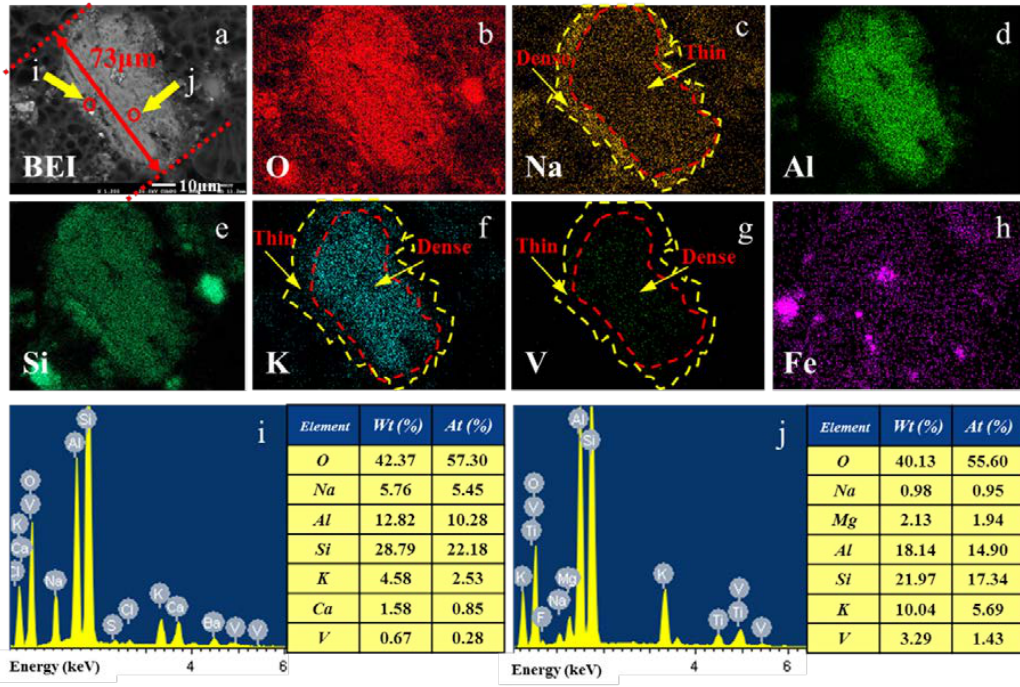
Figure 5. ( a ) BEI of acid leaching residue, EDS elemental distribution: ( b ) O, ( c ) Na, ( d ) Al, ( e ) Si, ( f ) K, ( g ) V, ( h ) Fe, and EDS spectra collected from BEI as marked by circle ( i ) at the outer margin and ( j ) at the interior of grain.